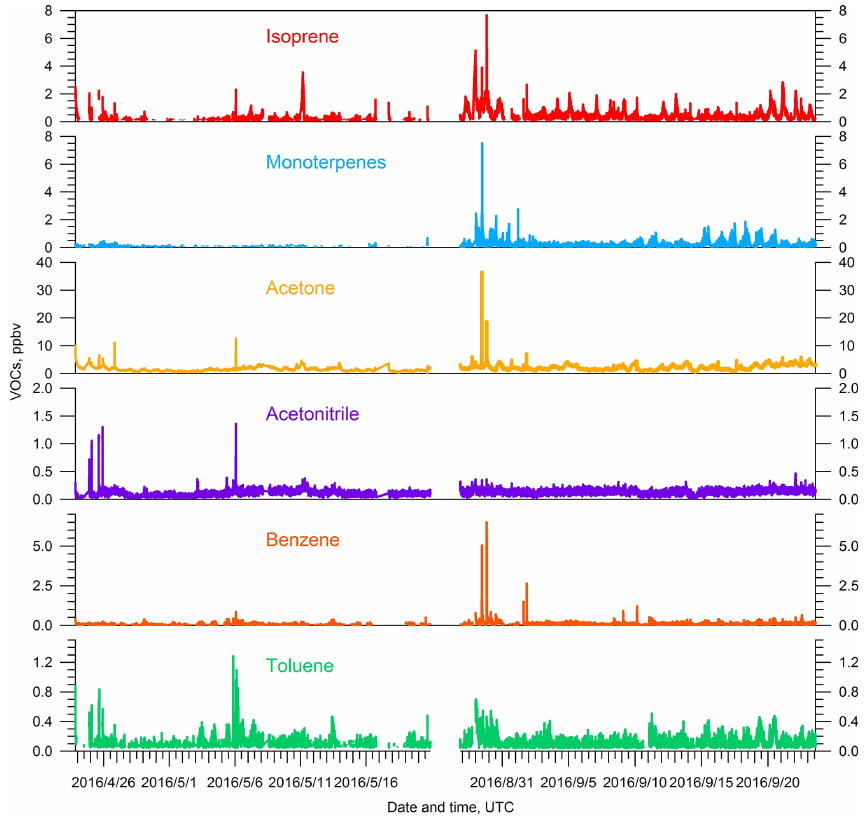
Figure 3. Time series of key VOCs, including isoprene, monoterpenes, acetone, acetonitrile, benzene, and toluene, for both the spring and summer IOPs during the HI-SCALE campaign. Table 2. A summary of gas-phase VOCs observed at the SGP site by PTR-MS during the two HI-SCALE IOPs. Measurement units are ppbv for all VOC species. Spring